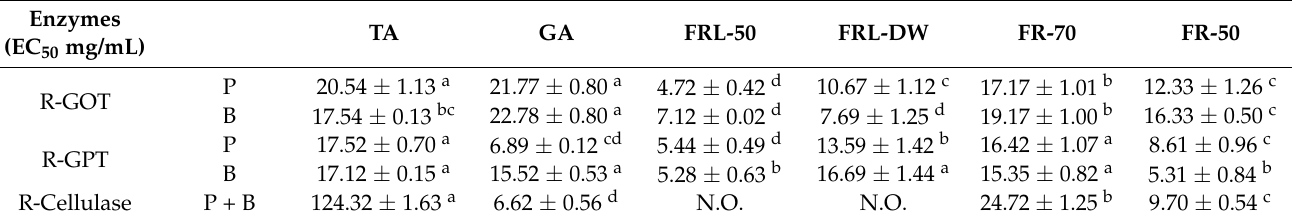
Table 2. Effect of proanthocyanidins from Ficus religiosa and F. racemosa leaves on inhibition activity (EC 50 ) of ruminal glutamic oxaloacetic transaminase (R-GOT), ruminal glutamic pyruvic transaminase (R-GPT), and ruminal R-Cellulase